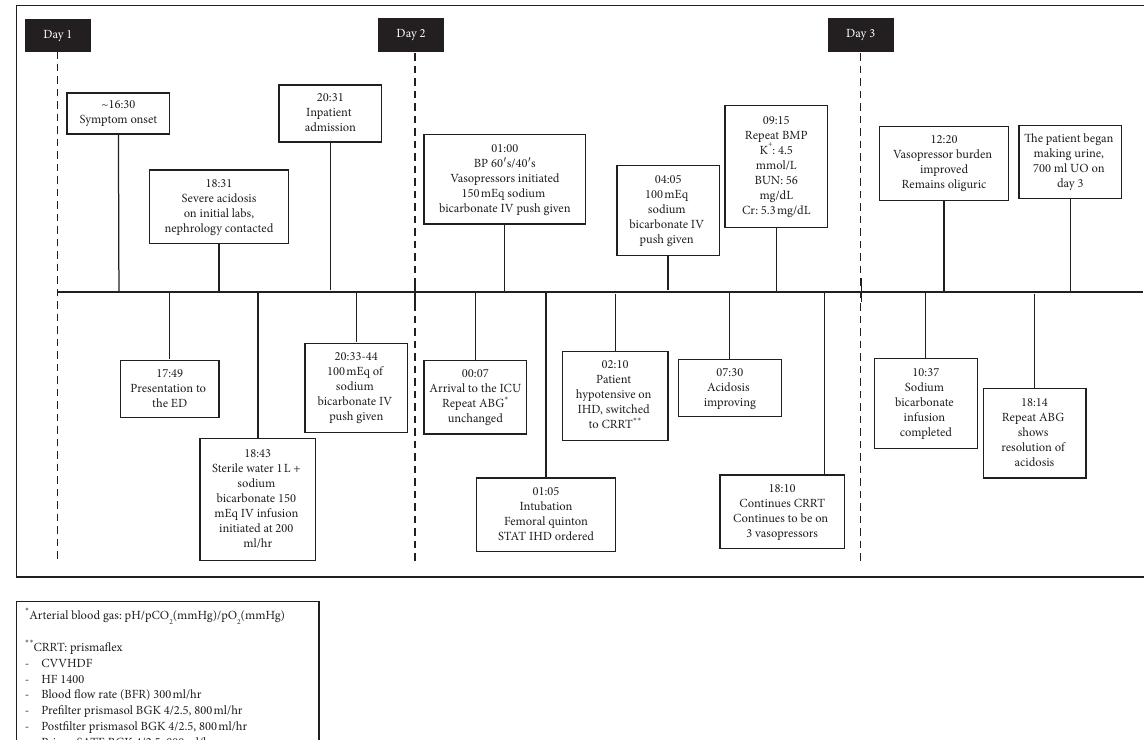
Figure 1: Timeline of clinical progression.